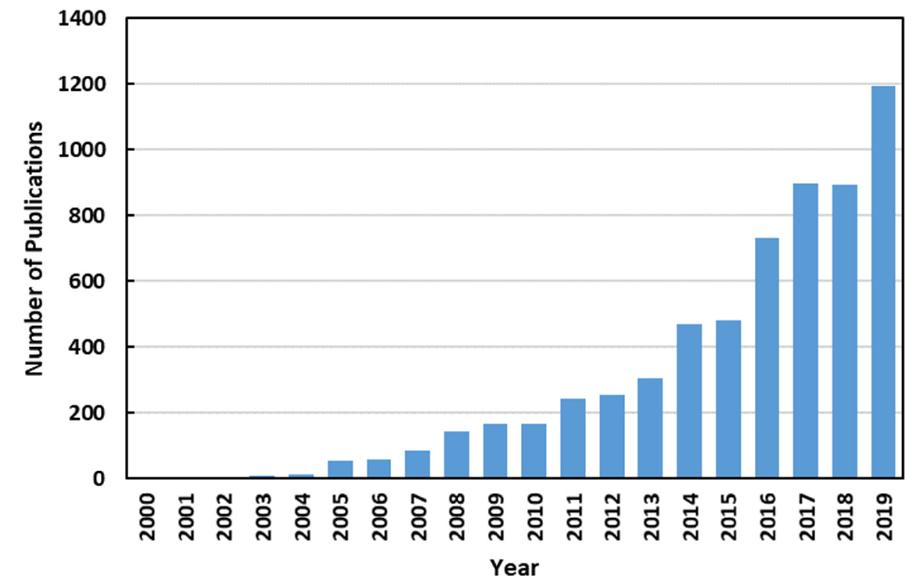
Figure 2. Web of Science record of nanofluids related publications [10].